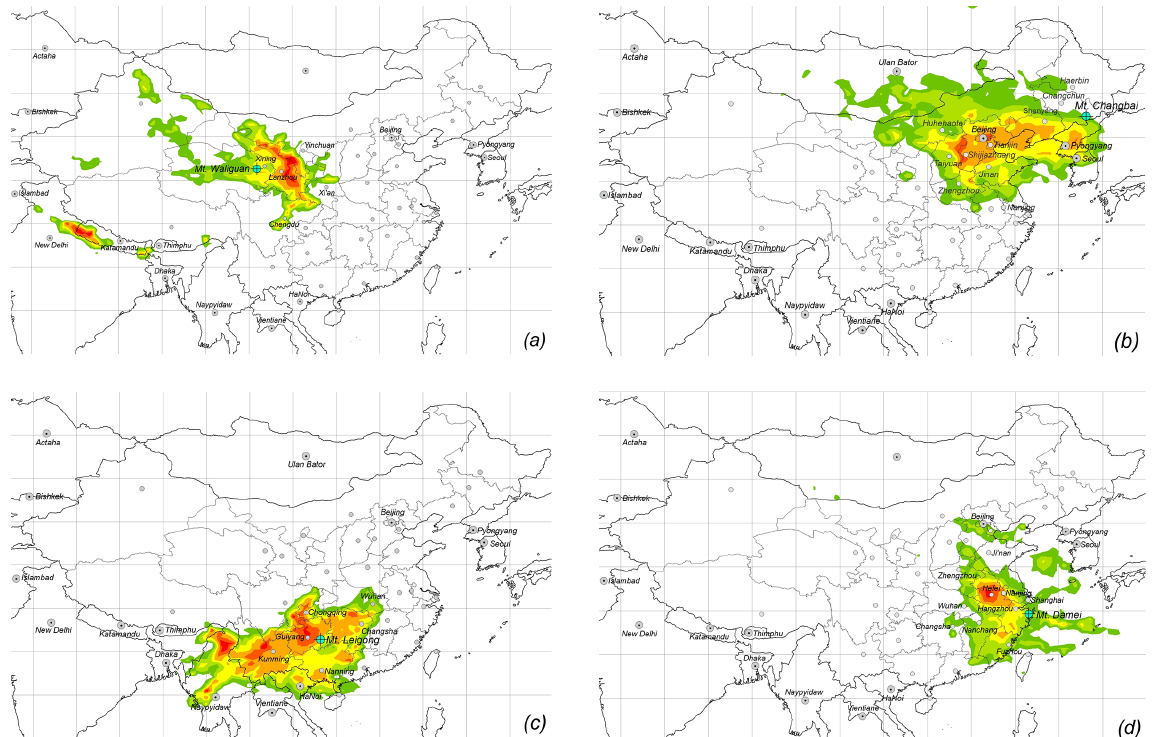
Figure 10. Potential source regions of GEM at (a) Mt. Waliguan, (b) Mt. Changbai, (c) Mt. Leigong, and (d) Mt. Damei (Fu et al.,